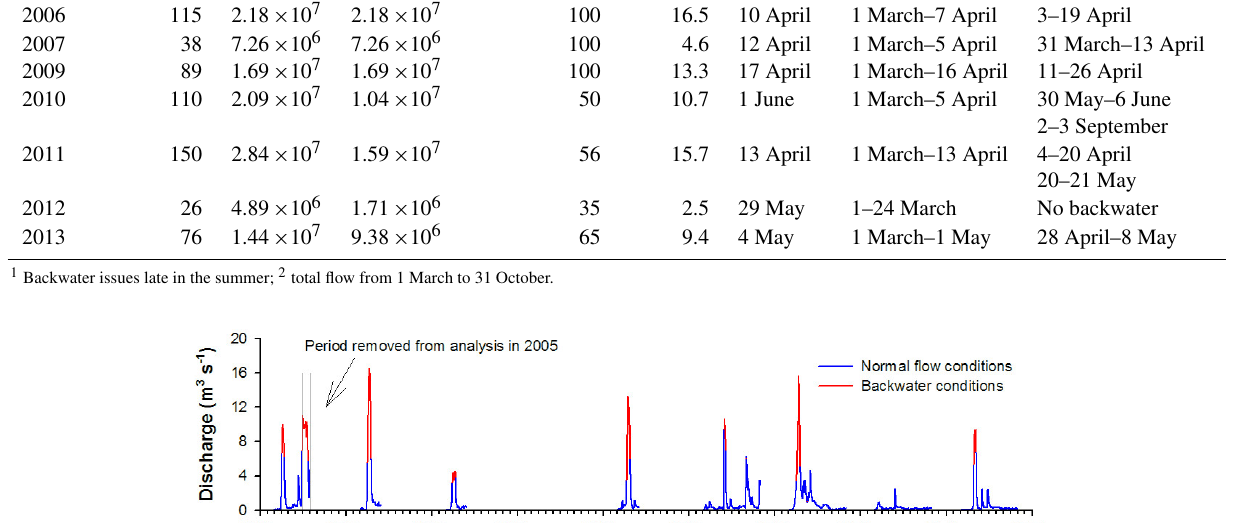
end of the ice period (Table 3). Ice conditions at peak